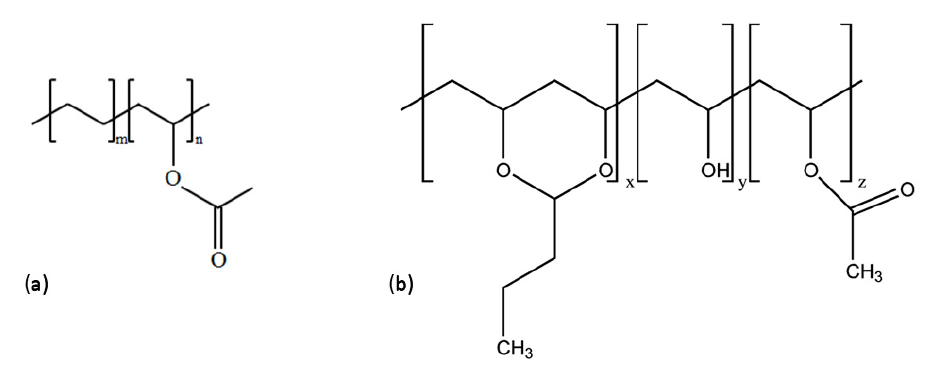
Figure 8. S tructure of EVA ( a ) and PVB ( b ) materials.